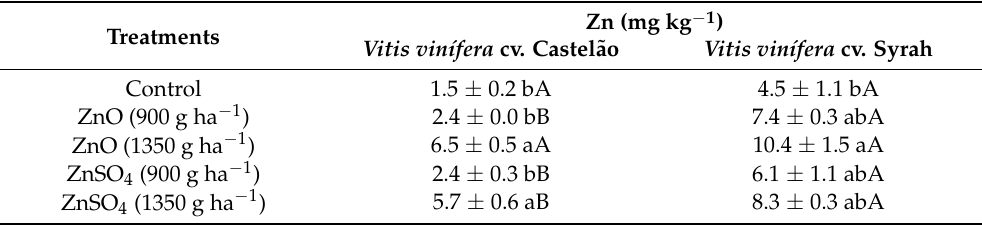
Table 3. Average ± S.E. ( n = 3) zinc concentrations in grapes at harvest of Vitis vinifera, varieties Castel ã o and Syrah. Letters a, b indicate significant differences among treatments in each variety, whereas letters A and B indicate the significant differences between each treatment of both varieties (statistical analysis using the two-way ANOVA test, p < 0.05).